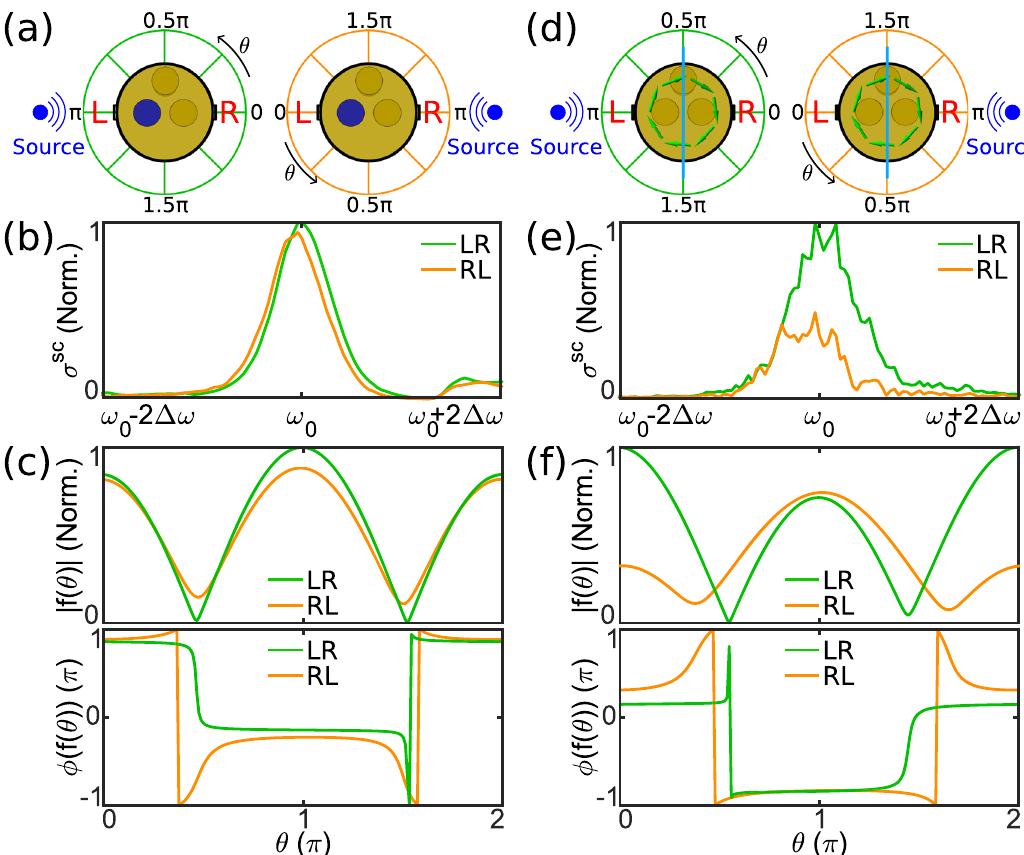
Fig. 4 Sound scattering and Willis coupling. a Even Willis scatterer excited by an incident wave from the left (green case) and right (orange case). b Measured total scattering width for the even Willis scatterer for an incident wave from the left (green line) and right (orange line). c Measured angular dependence of the pressure fi eld scattered by an even Willis scatterer in magntiude (top) and phase (bottom). d , e , f Similar to a , b , c for the odd Willis scatterer.